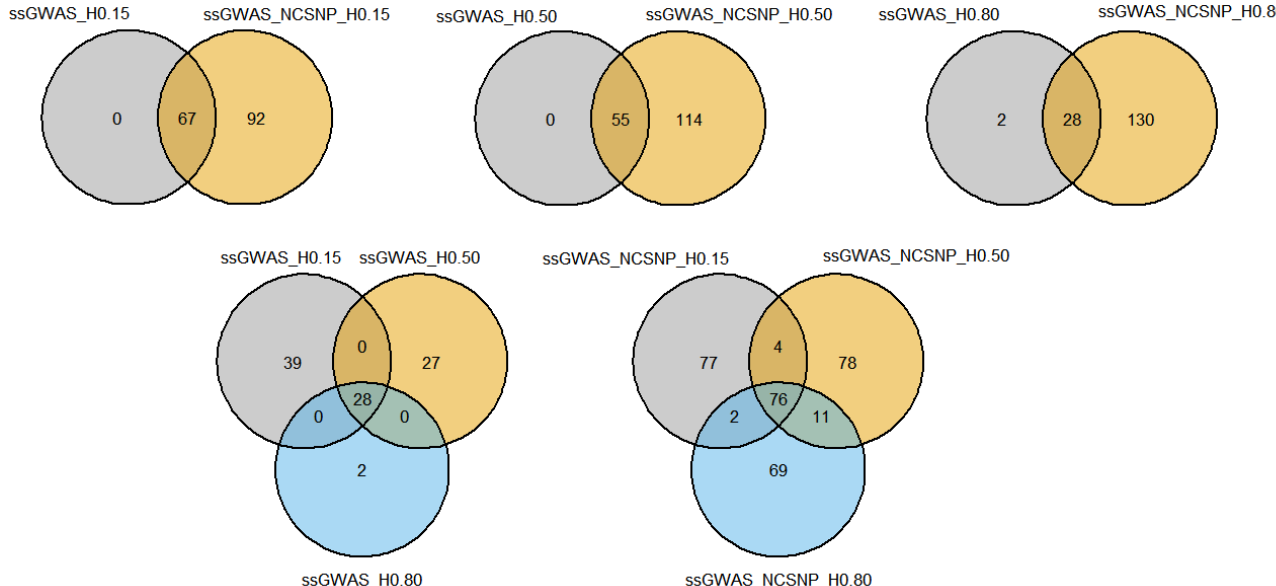
Figure 10. Venn diagrams showing the number of QTL overlapping among different single-step genome-wide association studies (ssGWAS) with haplotypes and non-clustered SNPs. ssGWAS_H0.15, ssGWAS_H0.50, and ssGWAS_H0.80: ssGWAS using only haplotypes from blocks with linkage disequilibrium (LD) thresholds of 0.15, 0.50, and 0.80, respec- tively; ssGWAS_NCSNP_H0.15, ssGWAS_NCSNP_H0.50, and ssGWAS_NCSNP_H0.80: ssGWAS using non-clustered SNPs and haplotypes from blocks with LD thresholds of 0.15, 0.50, and 0.80, respectively.